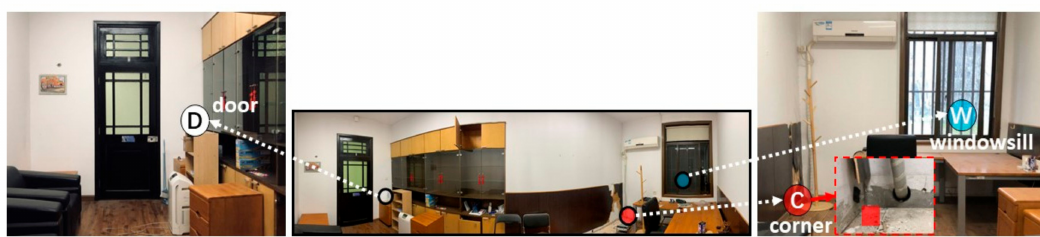
Figure 4. Indoor panorama of the monitored room, with three hygrothermometers monitoring the air temperature and relative